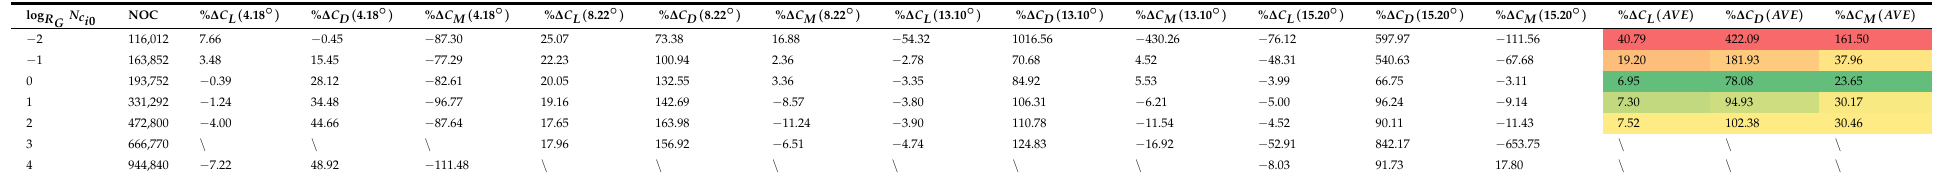
Table 11. Comparison of results of O-mesh based on various chord-wise spacings to that of experimental benchmark data adopted from [25] in relative differences with 296 nodes in chord-wise direction for reference setting.